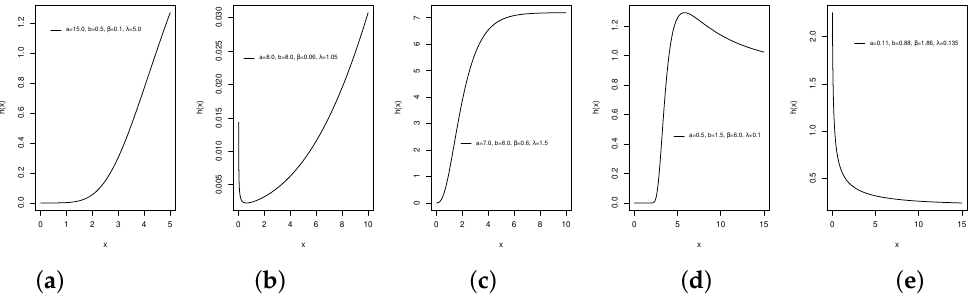
Figure 3. Sample of plots of the hrf of the NEKwE distribution: ( a ) increasing convex shape, ( b ) U shape, ( c ) increasing concave shape, ( d ) reversed 1 shape, and ( e ) decreasing